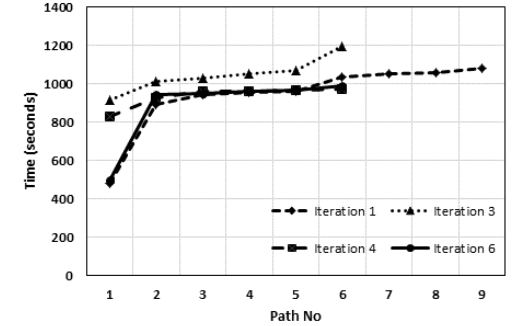
Figure 7. Solutions moving towards balanced